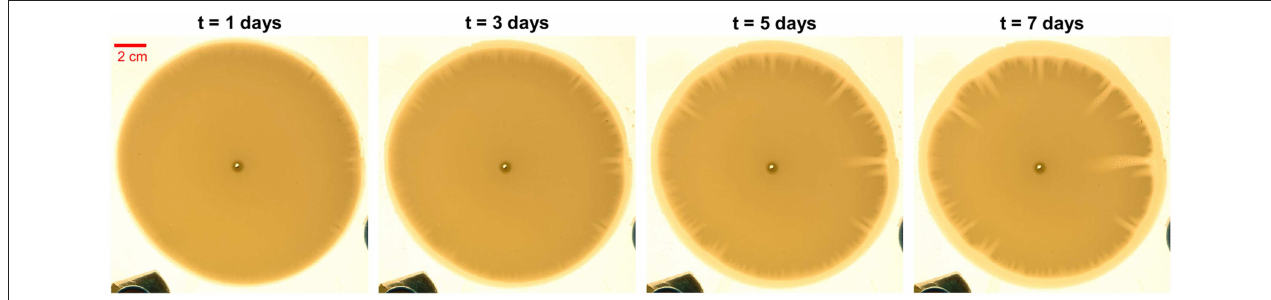
FIGURE 2 | Experimental photos of the developing fingering pattern at different moments of time. The time interval between the photos is 2 days. In the circular plaster sample, the dark yellow disk is the undissolved part of plaster and the light yellow part represents the dissolved or partially dissolved part.